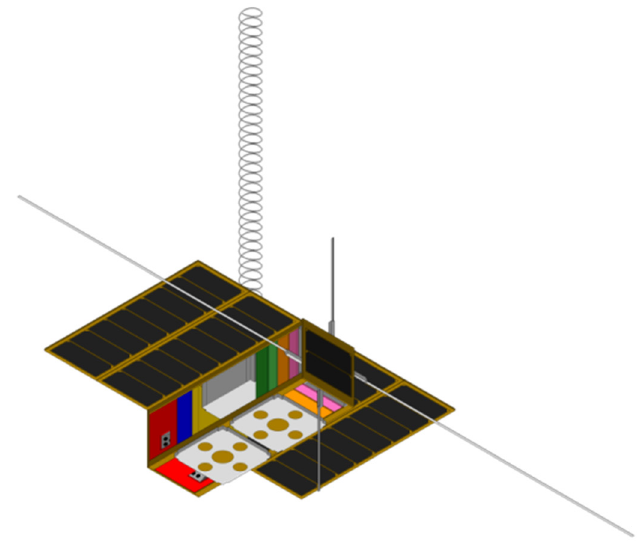
Figure 9. RMCSat architecture diagram. The satellite is a 3U CubeSat (10 × 10 × 30 cm) with deployable solar panels and payload antennas.